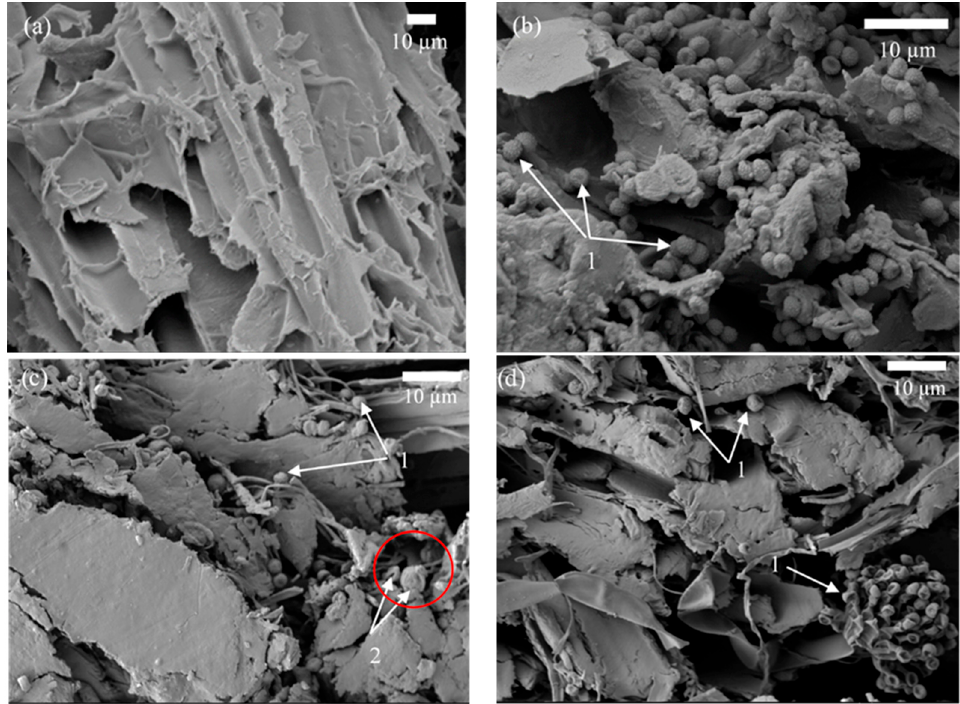
Figure 5. Microstructure of BcB with F composition as determined by SEM: ( a ) before incubation (magnification × 1000); ( b ) 6 months after incubation—1 mm depth of BcB (1— A. fumigatus ) (magnification × 2000); ( c ) 6 months after incubation—2–2.5 mm depth of the BcB (1— A. fumigatus , 2— Rh. oryzae ) (magnification × 1500); ( d ) 6 months after incubation—the middle of the BcB (1— A. fumigatus ) (magnification ×